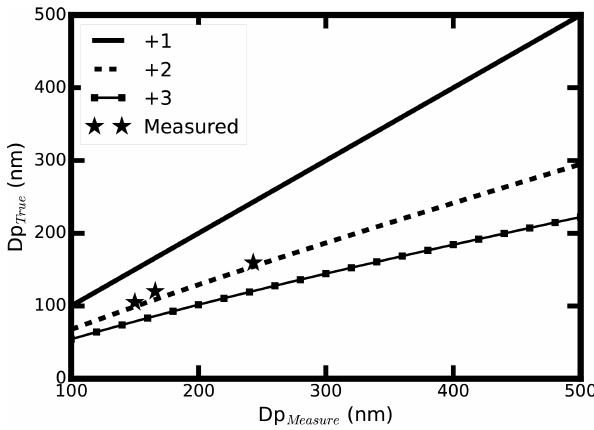
Figure 4. The relationship between the measured diameter by the DMA and the calculated aerosol diameter of different charges in the CPMA–SMPS